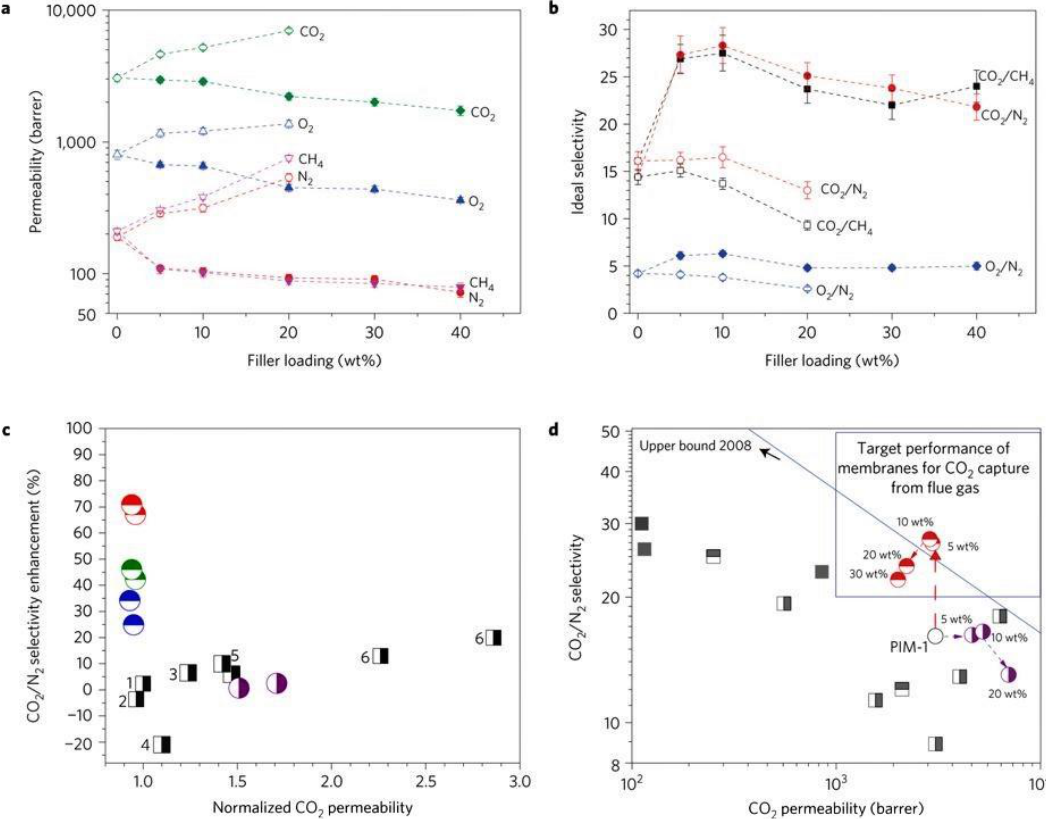
Figure 6. Gas permeability ( a ) and gas selectivity (b) of UiO-66-NH 2 (filled symbols) and pristine UiO-66 (open symbols) embedded in PIM-1. Comparison with literature results ( c ) and Robeson plot ( d ) for CO 2 /N 2 separation [90]. With copyright permission from © 2017, Springer Nature.